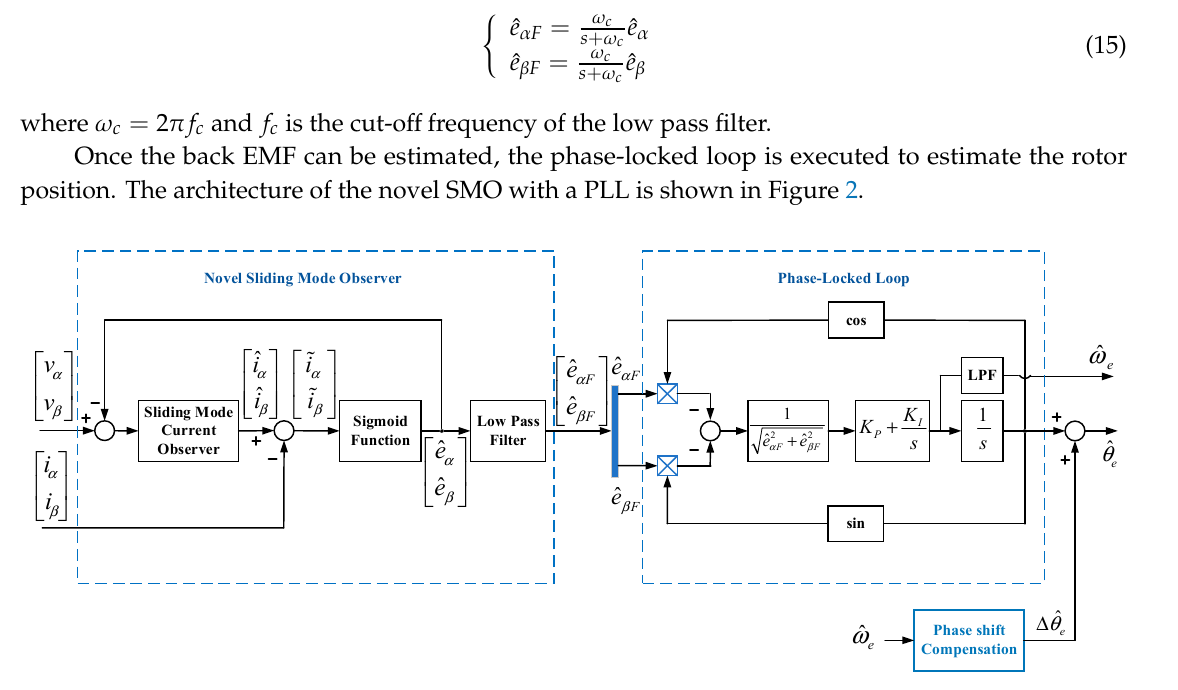
Figure 2. Novel sliding mode observer with a phase-locked loop.